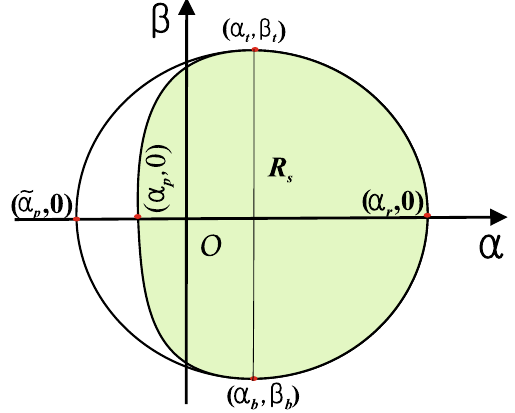
Fig. 6 Schematic representation of the observables for rotating black holes [17]